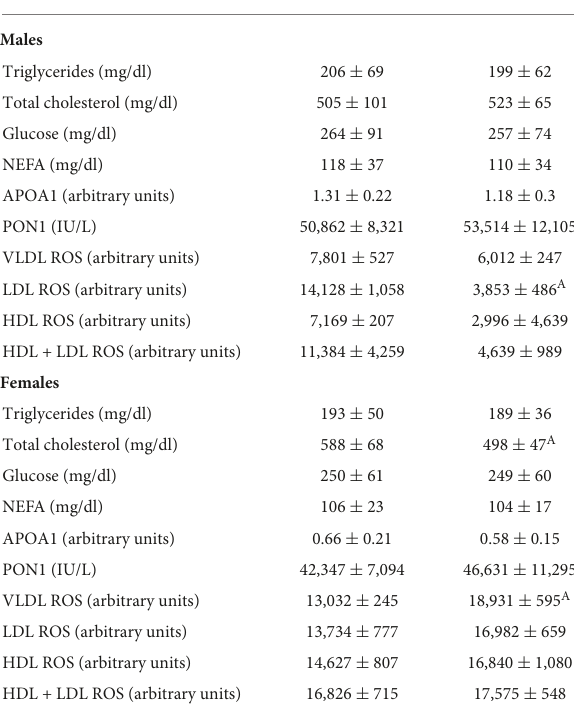
Dataareindividualvalueswiththeirmeans ± SDforeachgroup.Statisticalanalysiswas carriedoutusingStudent’s t -test. A P <